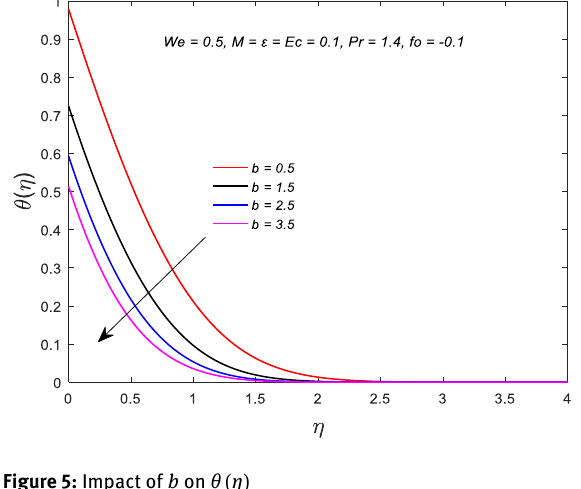
Figure 5: Impact of b on θ ( η )